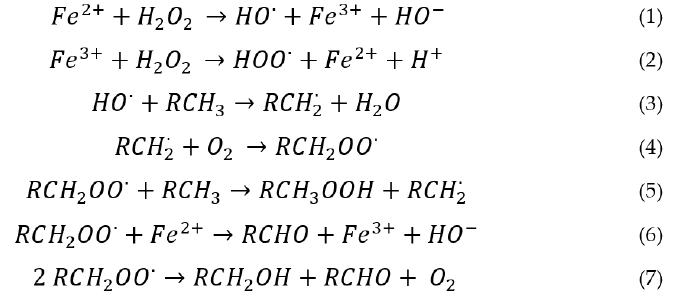
Scheme 2. Proposed mechanism for the oxidation of p- xylene catalyzed by a C-scorpionate iron(II)